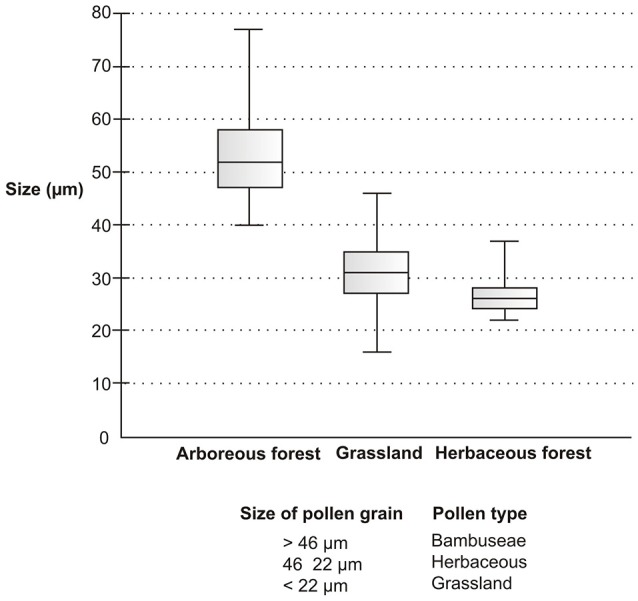
Chart box plot of the diameters of the pollen grains. The bold horizontal line within the box represents the median. The box shows 50% of the interquartile range, and whiskers the total variation.